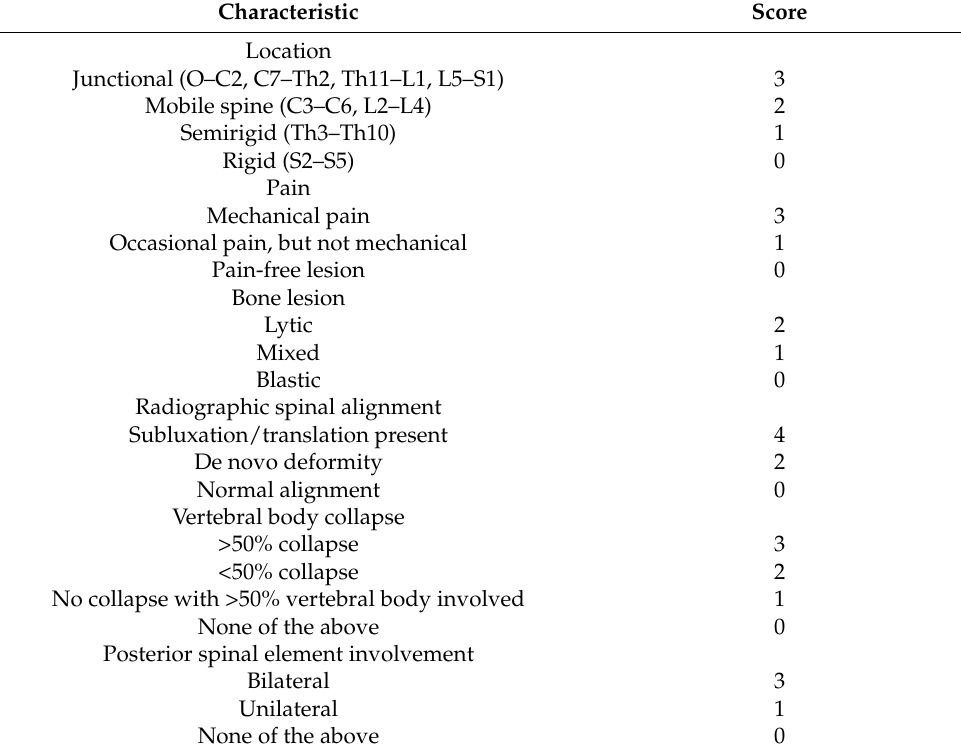
Table 4. Spinal Instability Neoplastic Score